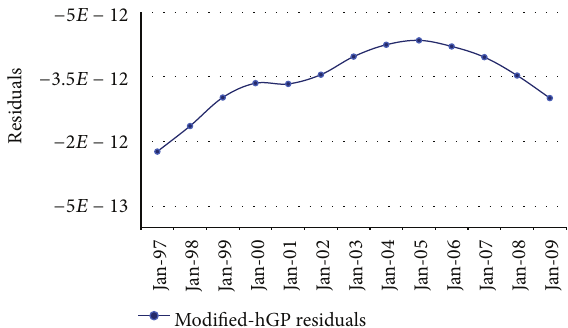
Figure 12: Residuals of the modified-hGP model in fitting of the total number of OECD